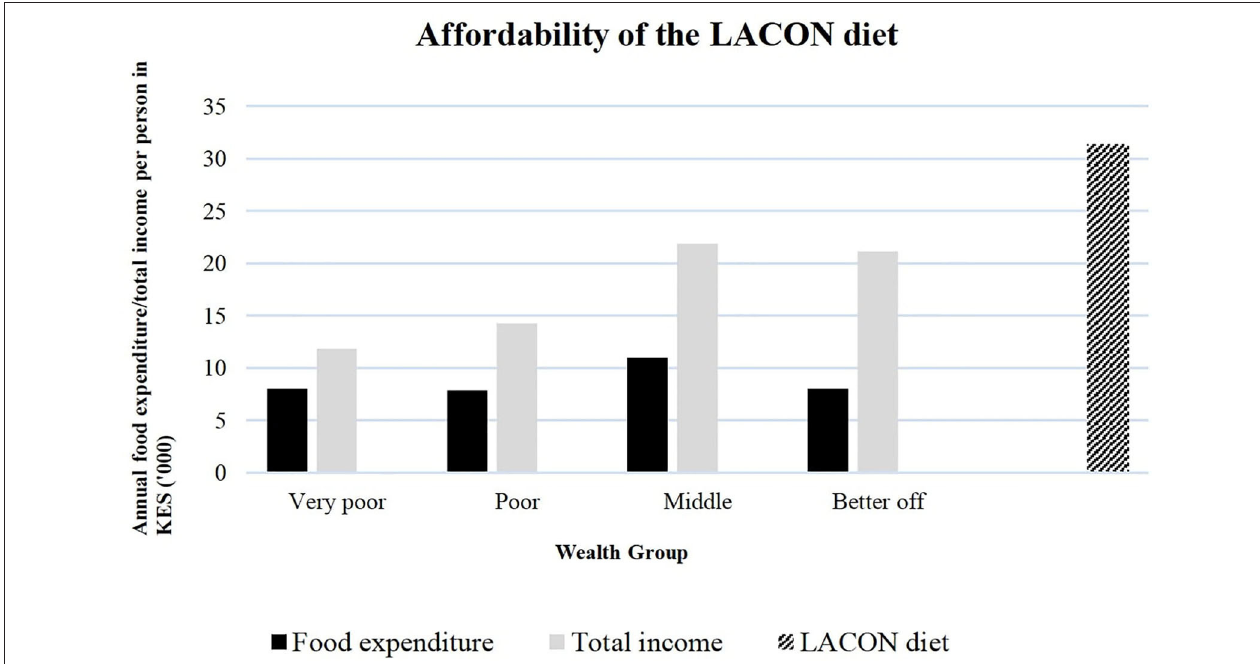
FIGURE 3 | Affordability of the locally adapted cost optimized nutritious (LACON) diet–modeled with three wild vegetables–per person for the various wealth groups in Turkana County, Kenya.